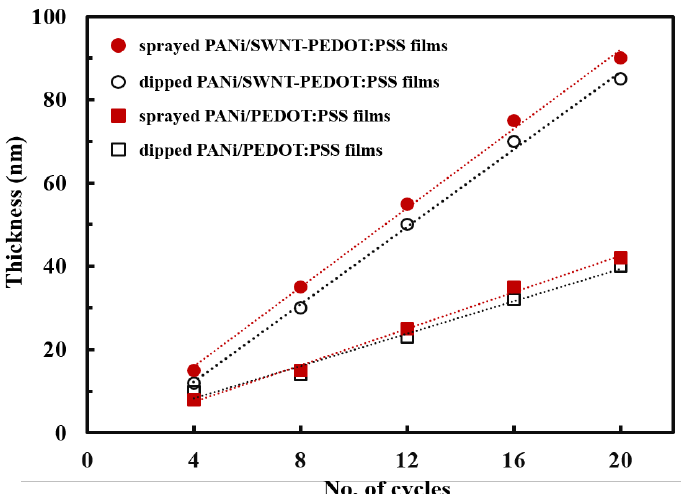
Figure 2. Thickness of the films with and without SWNT deposited via dipping and spraying method. The symbols represent the following: (circles) PANi/SWNT-PEDOT:PSS assemblies built by the spraying process (closed symbols) and traditional dipping approach (open symbols); (squares) PANi/PEDOT:PSS films formed by the spraying process (closed symbols) and traditional dipping method (open symbols).